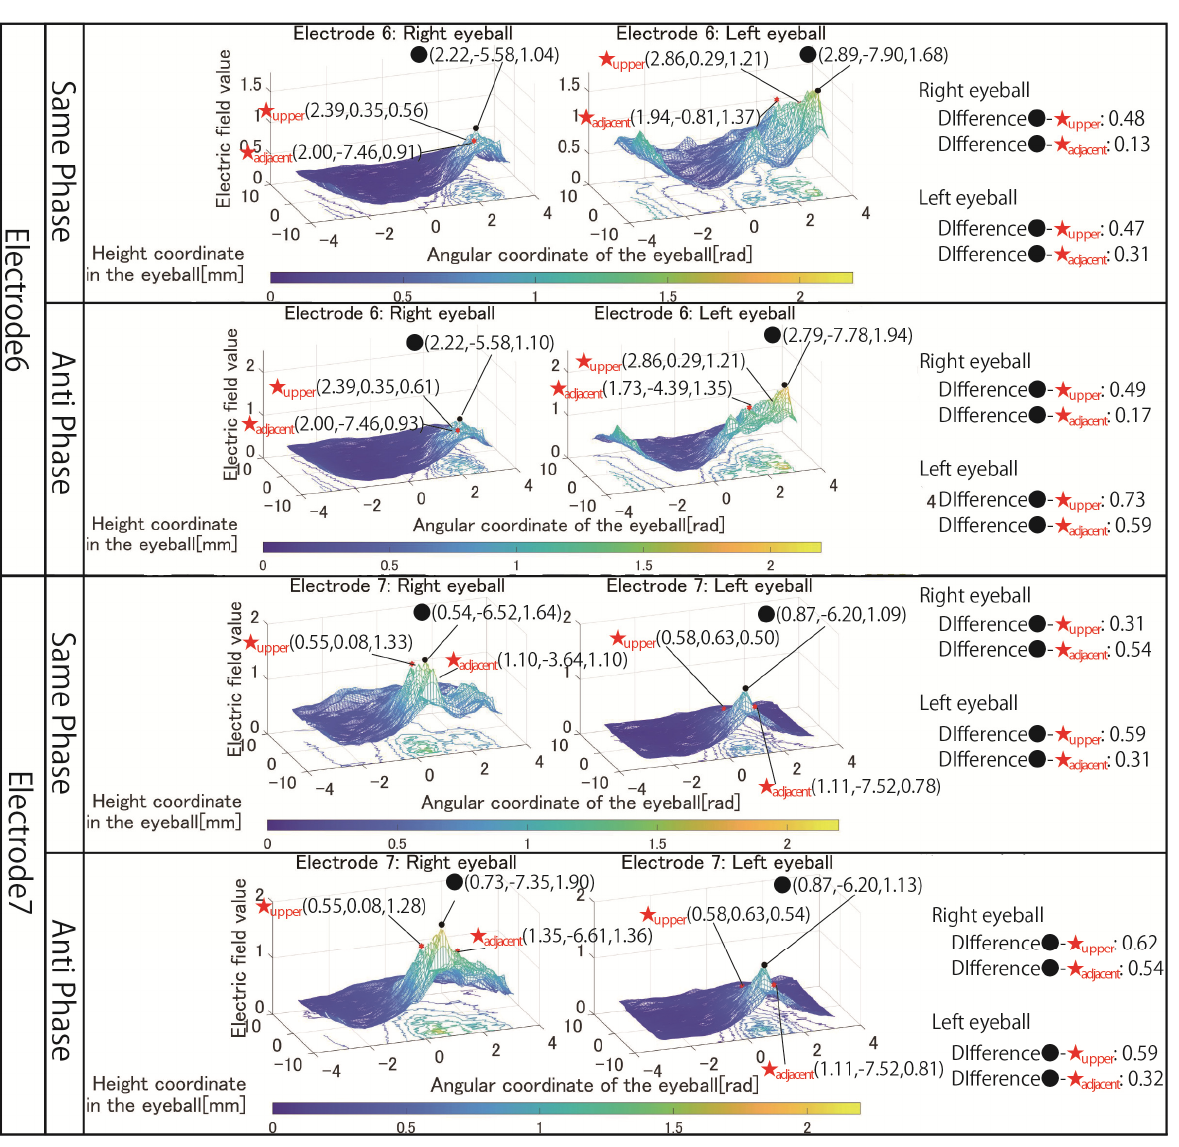
Figure 13. Simulation result with revised electrode arrangement to stimulate temporal nasal eyeballs.